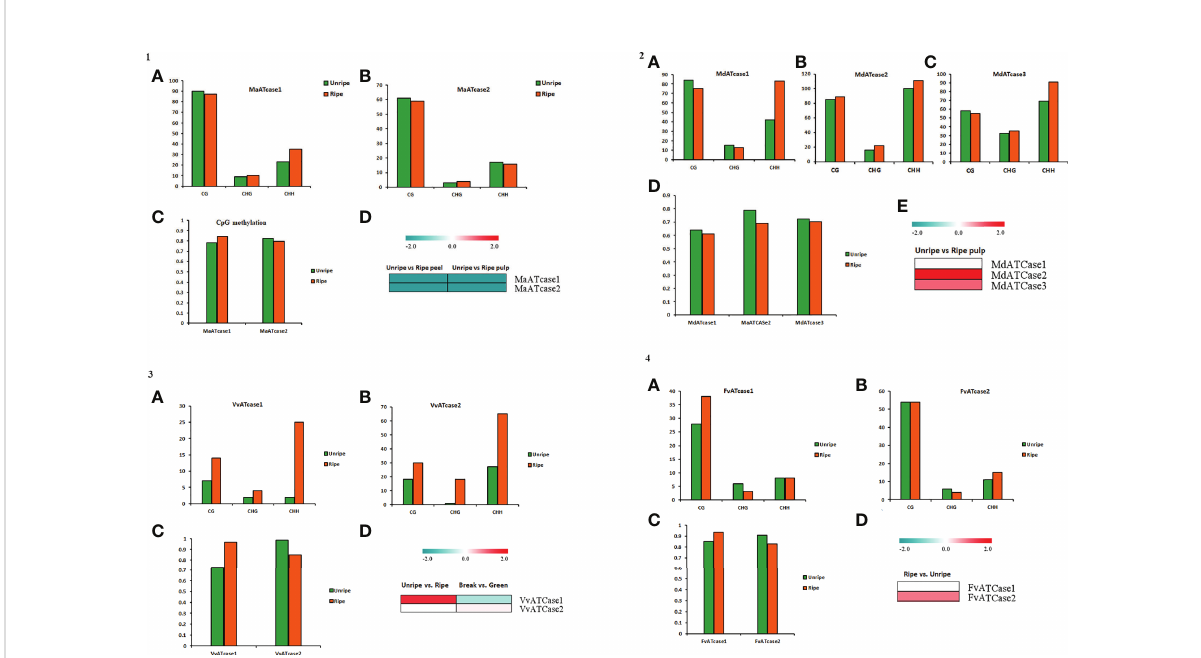
FIGURE 6 The panel representation for the status of CG, CHG, and CHH methylation sites in ATcase genes of banana (panel 1), apple (panel 2), grape (panel 3), and strawberry (panel 4). Status of CG, CHG, and CHH methylation sites in ATcase genes of banana, represented by bar plots (A, B) in unripe and ripe pulp conditions. Level of CpG methylation in banana Atcase genes (C) , represented by a bar plot, and compared with log2 fold change expression, represented by a heat map (D) . Status of CG, CHG, and CHH methylation sites in ATcase genes of apple, represented by bar plots (A – C) in unripe and ripe pulp conditions. Level of CpG methylation in banana Atcase genes (D) , represented by a bar plot, and compared with log2 fold change expression, represented by a heat map (E) . Status of CG, CHG, and CHH methylation sites in ATcase genes of grape, represented by bar plots (A, B) in unripe and ripe pulp conditions. Level of CpG methylation in grape Atcase genes (C) , represented by a bar plot, and compared with log2 fold change expression, represented by a heat map (D) . Status of CG, CHG, and CHH methylation sites in ATcase genes of strawberry, represented by bar plots (A, B) in unripe and ripe pulp conditions. Level of CpG methylation in strawberry Atcase genes (C) , represented by a bar plot, and compared with log2-fold change expression, represented by a heat map (D)